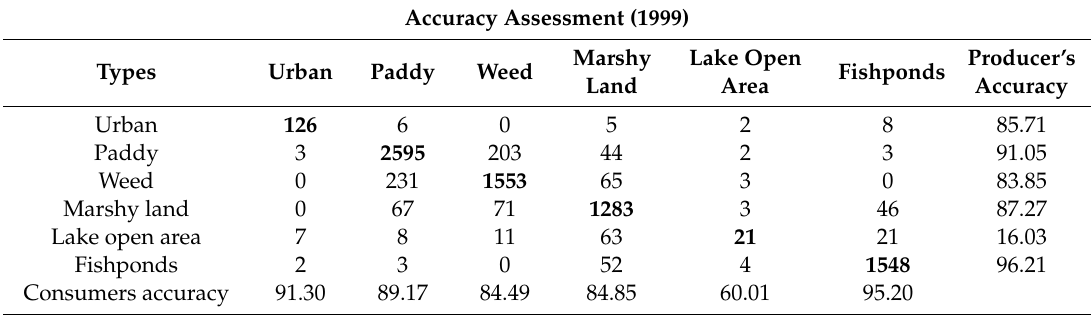
Table 1. Accuracy assessment test of the land use types for 1999, 2008, and 2018.